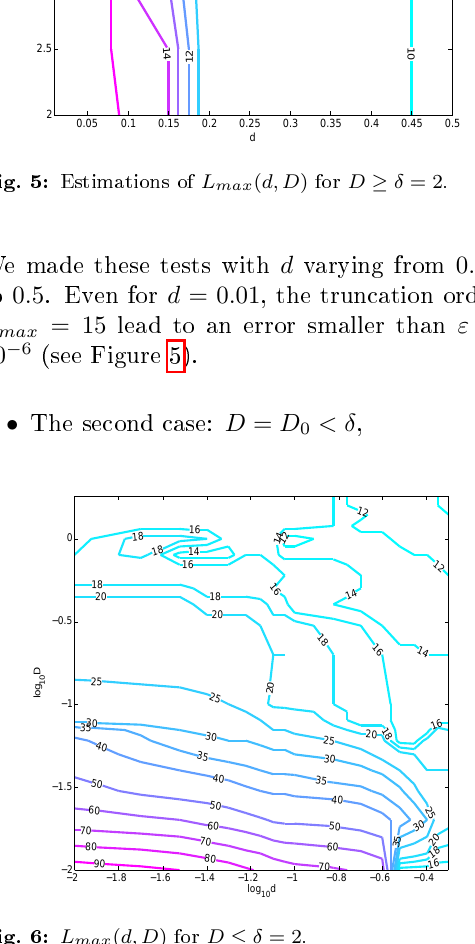
Fig. 6: L max ( d,D ) for D ≤ δ = 2 .